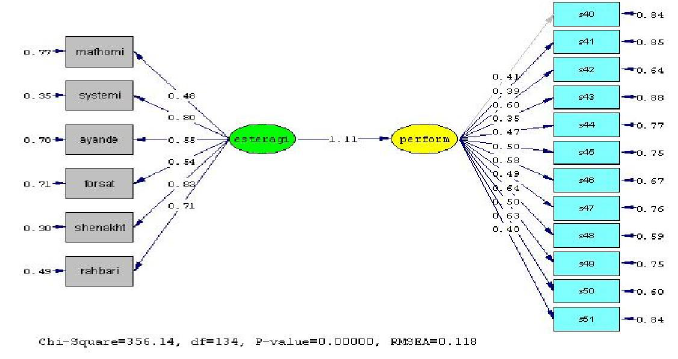
Fig. 2. The impact of strategic thinking dimensions on the performance of Mashhad municipal managers Degrees of Freedom = 134 Minimum Fit Function Chi-Square = 397.66 (P = 0.0( Normal Theory Weighted Least Squares Chi-Square = 356.14 (P = 0.0( Estimated Non-centrality Parameter (NCP) = 222.14 90 Percent Confidence Interval for NCP = (169.99 ; 281.96( Minimum Fit Function Value = 3.34 Population Discrepancy Function Value (F0) = 1.87 90 Percent Confidence Interval for F0 = (1.43 ; 2.37( Root Mean Square Error of Approximation (RMSEA) = 0.12 90 Percent Confidence Interval for RMSEA = (0.10 ; 0.13( P-Value for Test of Close Fit (RMSEA < 0.05) = 0.00